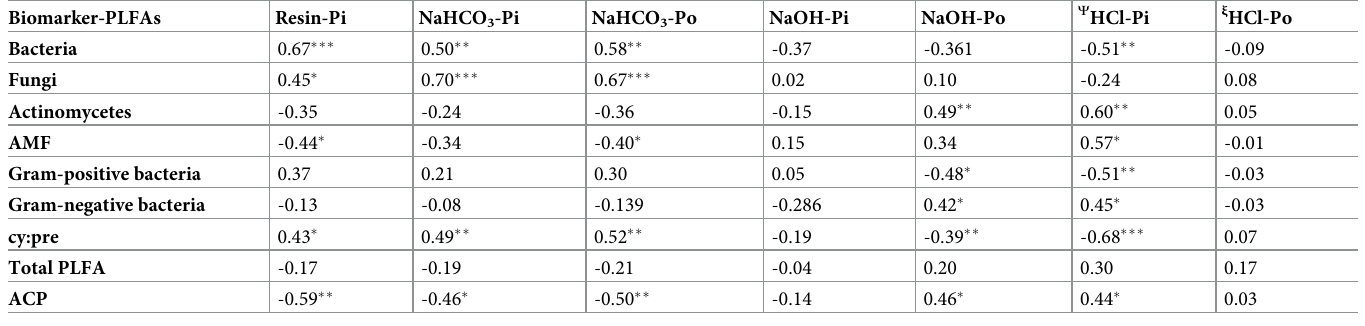
Fig 2. Analysis of distribution patterns of soil microbial communities along the elevation gradient. (a) Redundancy analysis (RDA) of the PLFA dataset for the 27 soil samples using 44 PLFAs as species and 14 environmental variables as explanatory variables. The significance of the relations between the ordination and explanatory variables is denoted as follows: � p < 0.05, �� p < 0.01, ��� p < 0.001. (b) A partial RDA showed the proportion of the variance in PLFAs composition explained by the P factors (i.e., P fractions) and other factors (i.e., MAT, MAP, pH, TOC, TN and soil moisture). (c) Nonmetric multidimensional scaling (NMDS) analysis of microbial PLFAs across alpine and subalpine zones, ranked by elevation (low-elevation sites: 3500–3700 m a.s.l., mid-elevation sites: 3780–3930 m a.s.l., high-elevation sites: 3980–4100 m a.s.l.).